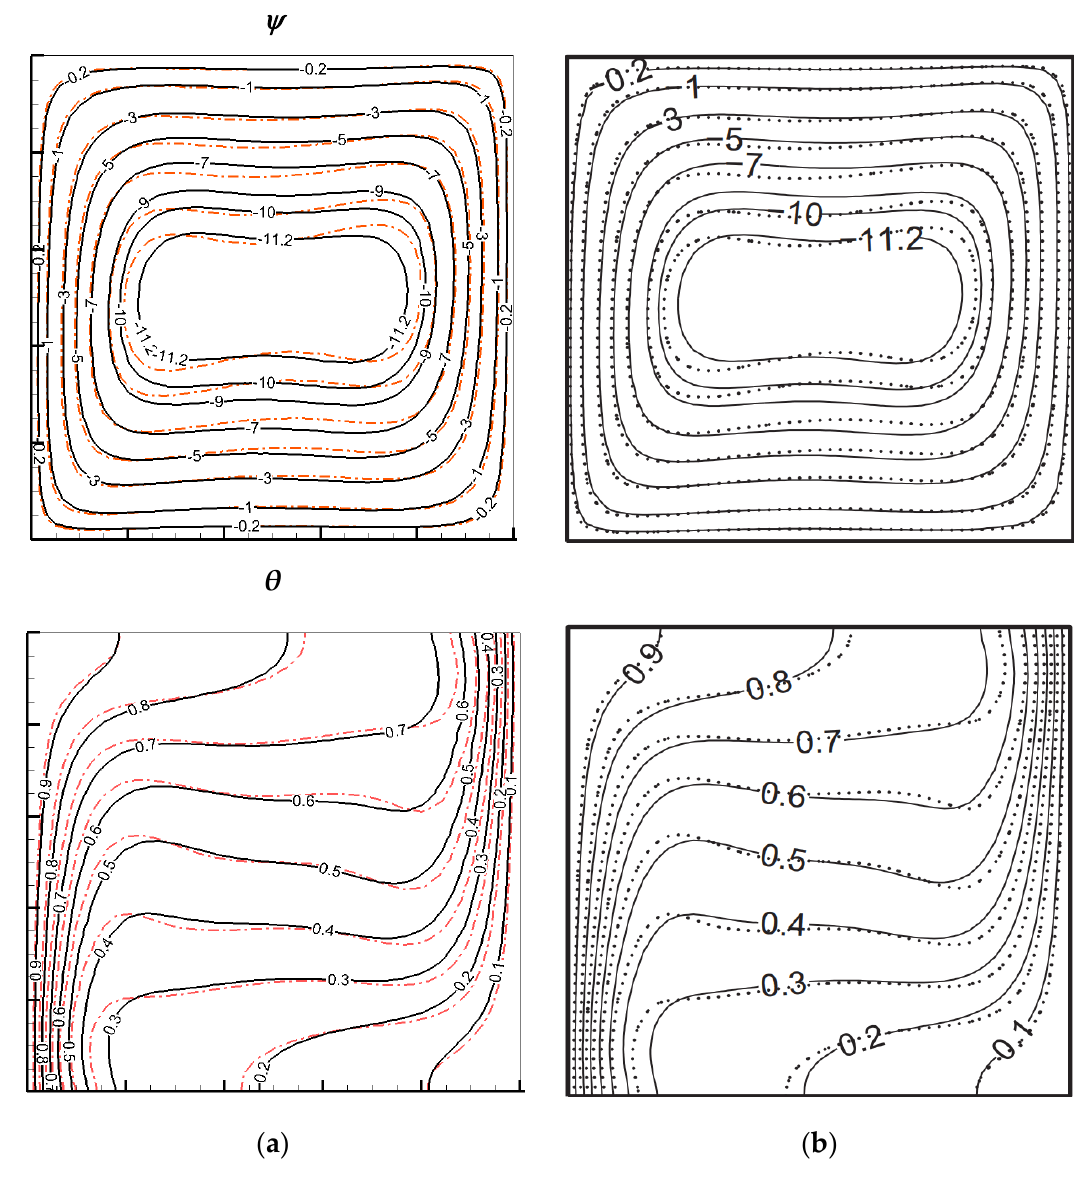
Figure 3. Comparison of the ( a ) present results of isothermal patterns with ( b ) Basak and Chamkha [24] ( θ ) and stream function ( Ψ ) for Cu–water nanofluids with Ra = 10 5 and φ = 0.1. Table 3. Comparison of average Nusselt number obtained in the present simulation and those of Basak and Chamkha [24], for Cu–water nanofluid. Rayleigh Number ( Ra